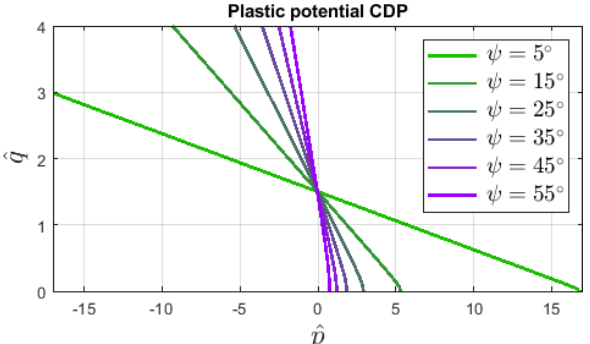
Figure 3. Influence of dilatancy angle ψ in the shape of plastic potential surfaces G p plane, CDP model, Equation (6), f (cid:48) t = 3 MPa, E =